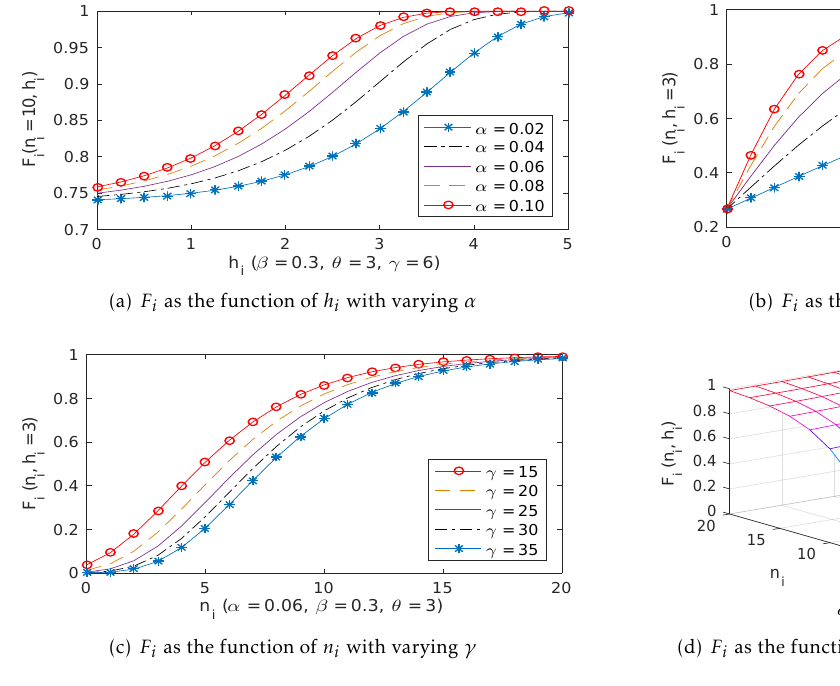
Figure 3. F changes with α , β and γ . i ( n i , h i )